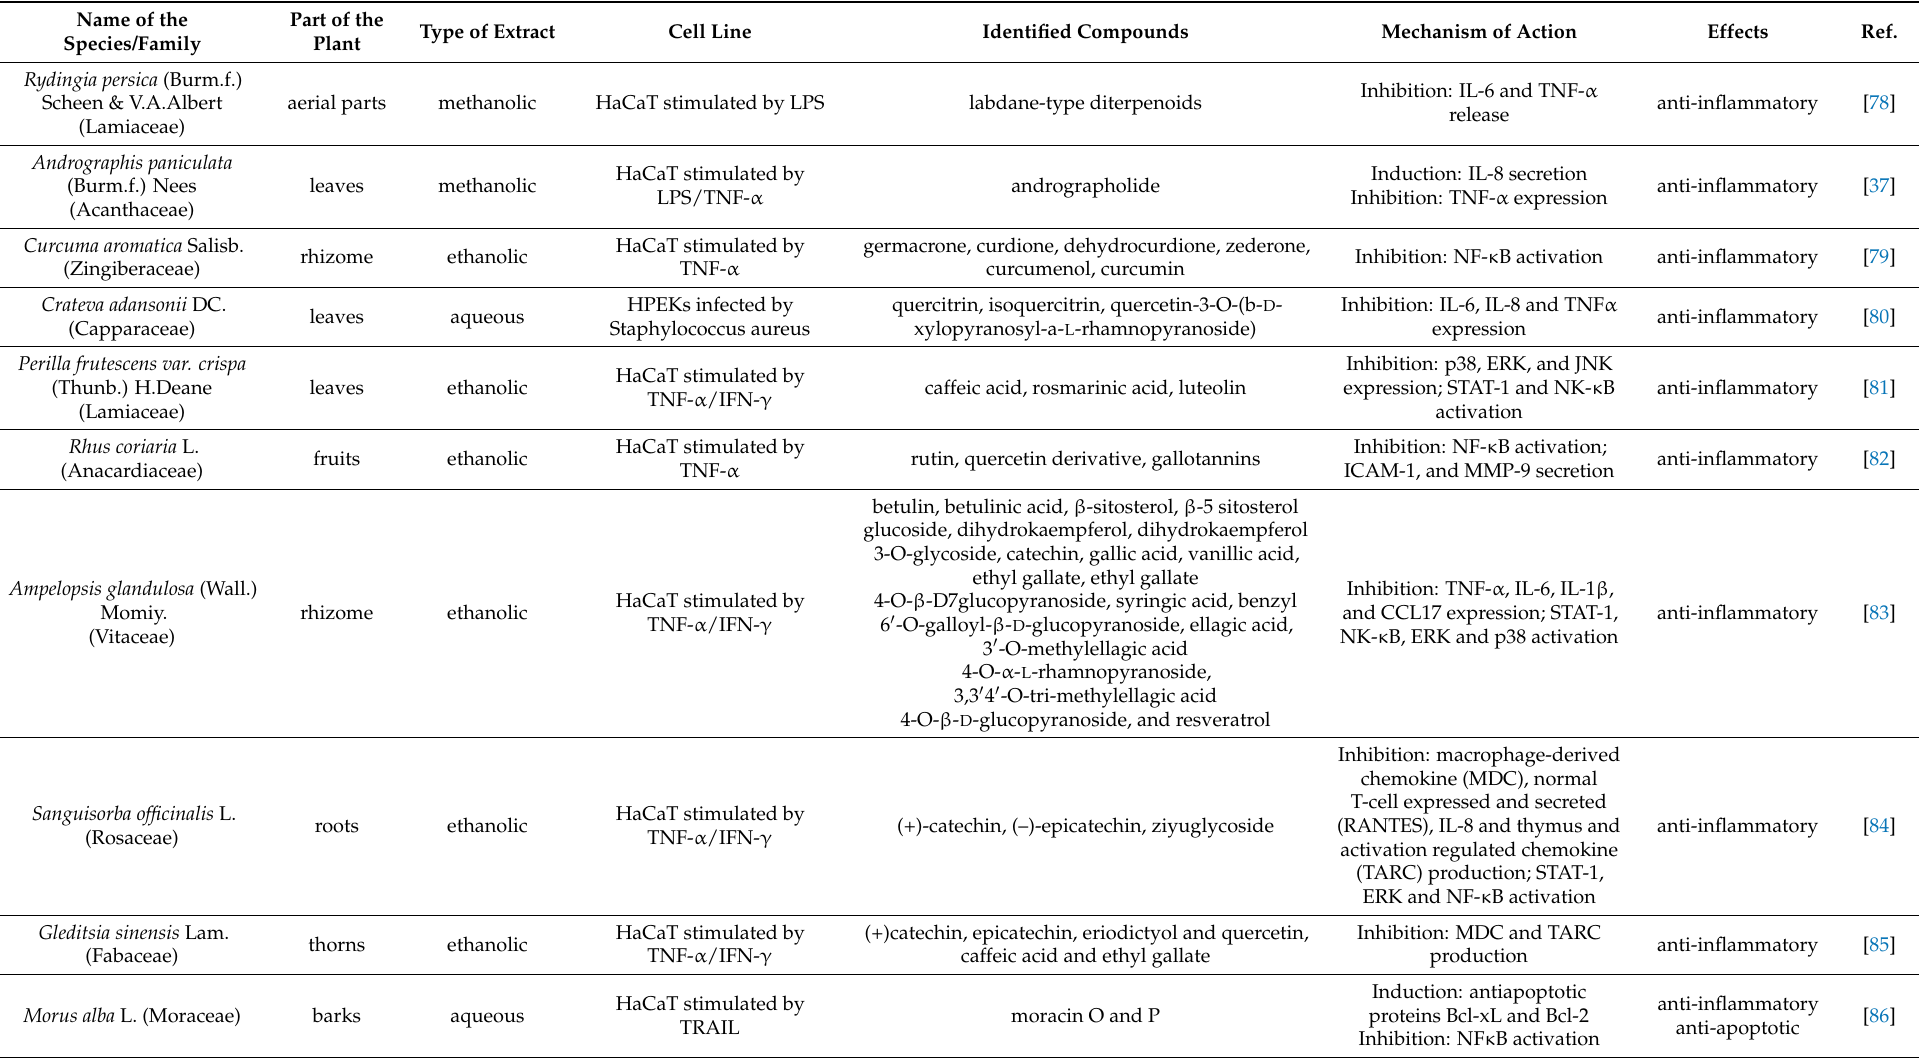
Table 2. Selected plant extracts from different species with identified compounds and their in vitro effect on TNF- α or IFN- γ -stimulated human